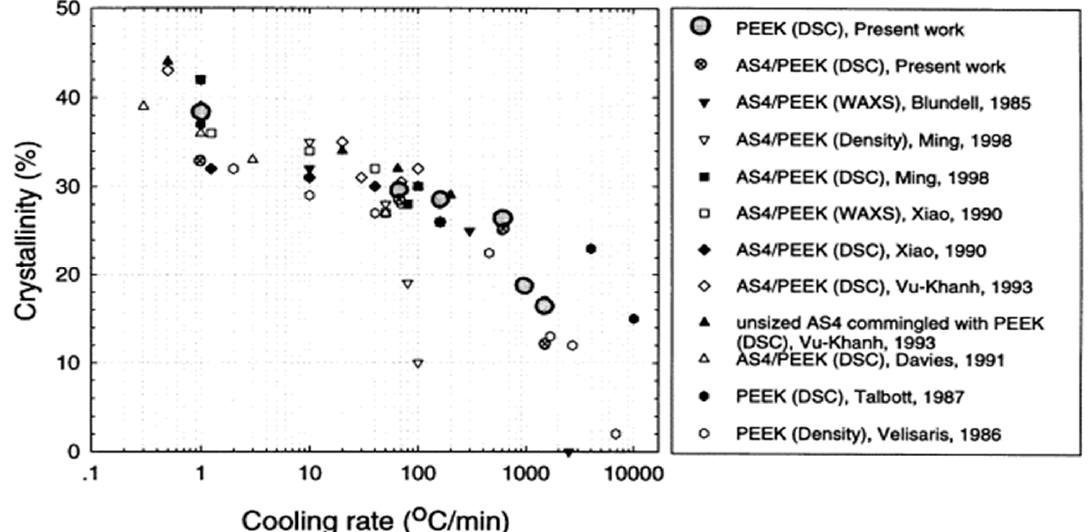
Figure 6. Crystallinity versus cooling rate for PEEK resin and PEEK–carbon fiber composites. Measurement methods are shown in parentheses [29].